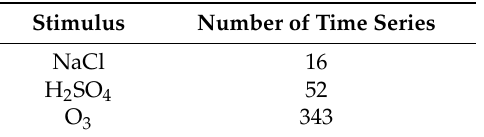
Table 2. Number of time series used for each